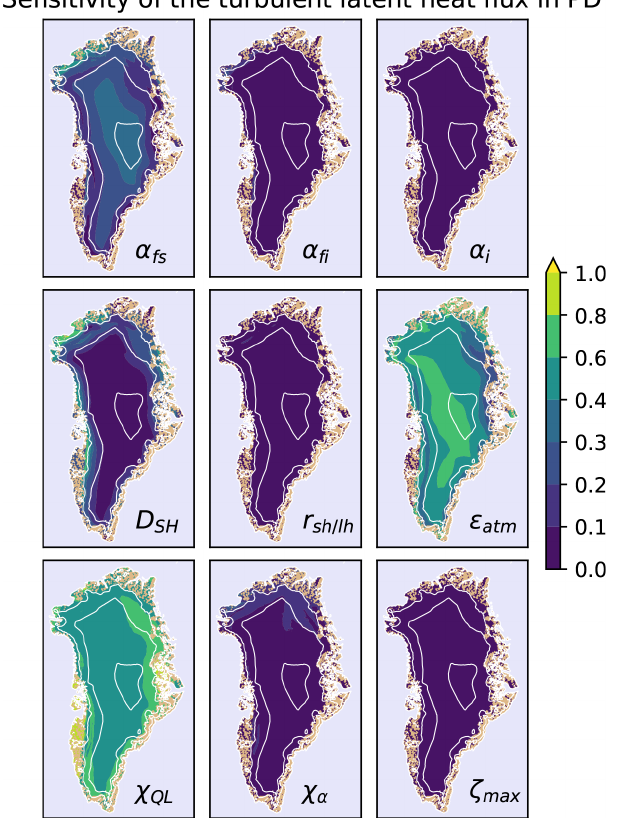
Figure A3. Global sensitivity of the turbulent latent heat flux in the PD. The total sensitivity index of Q L of every parameter for the PD is displayed for every ice-covered grid cell. The ice-free land is in brown; the ocean is in